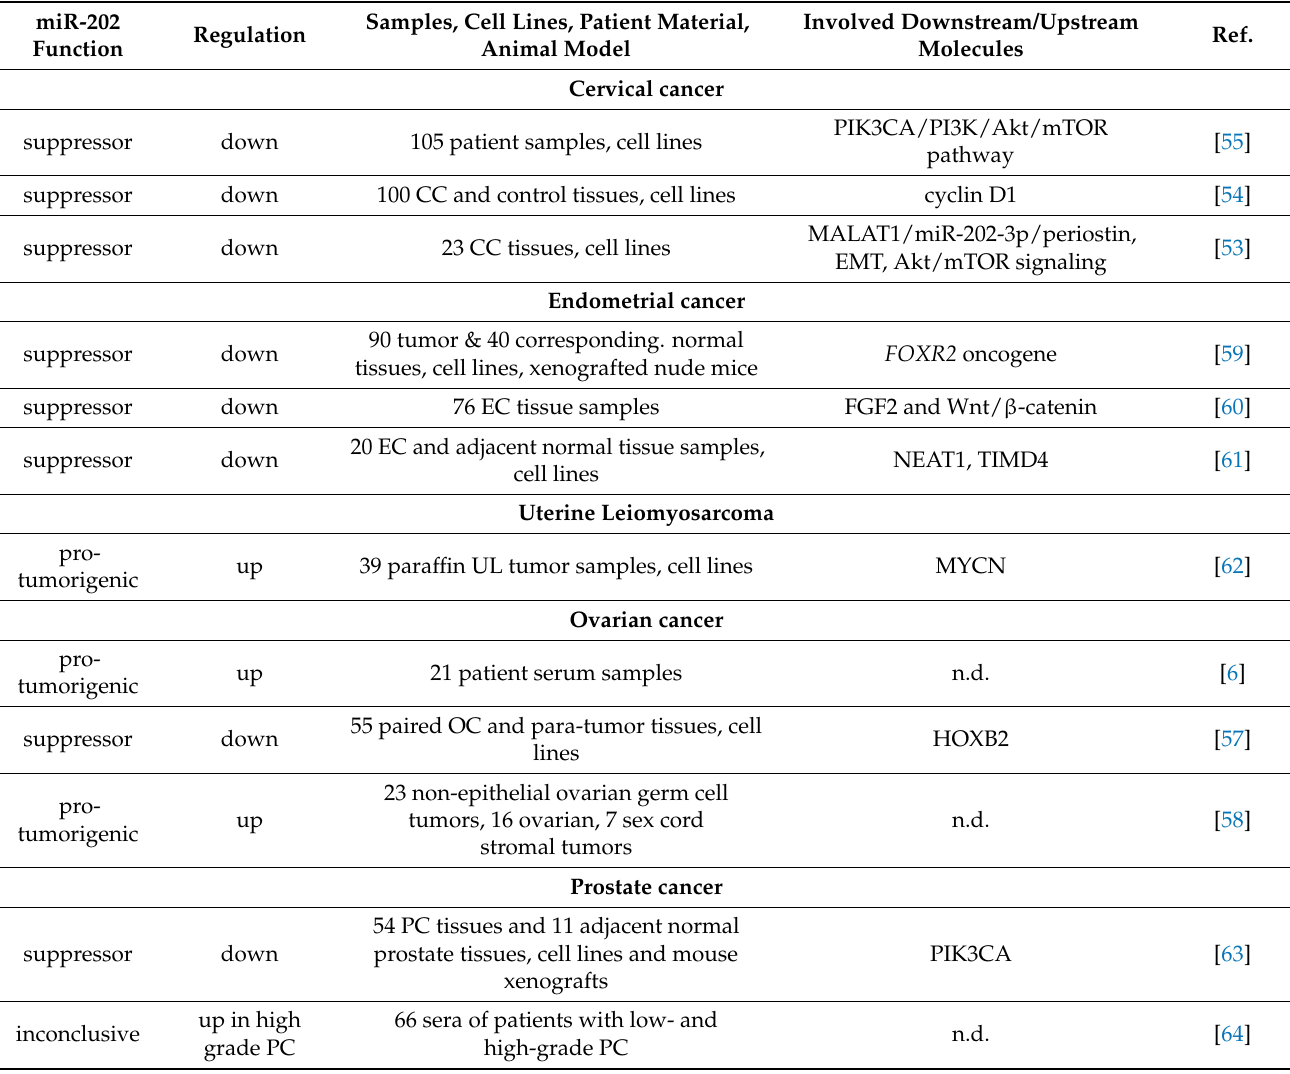
Table 4. Reproductive system and gynecological cancers and role of